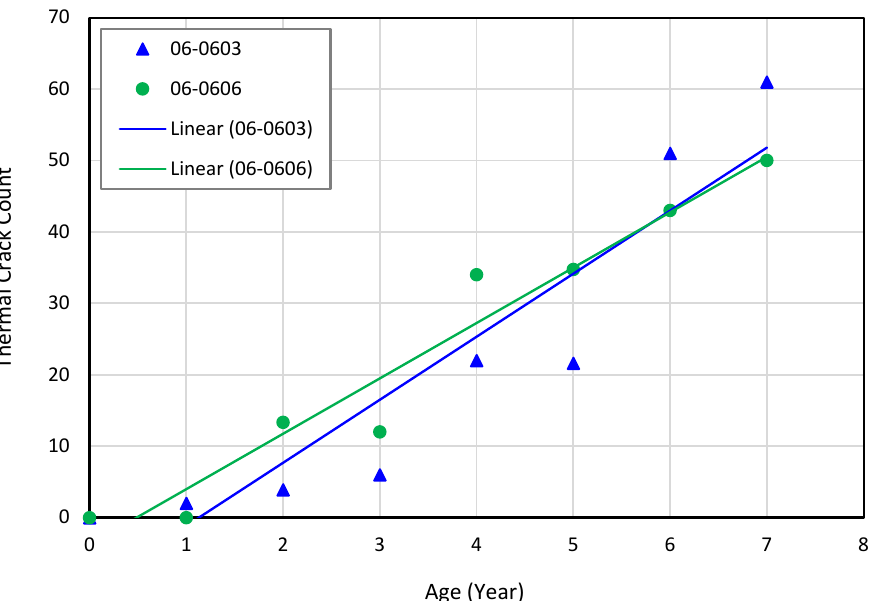
Figure 8. Thermal crack counts on the LTPP test sections located in CA.